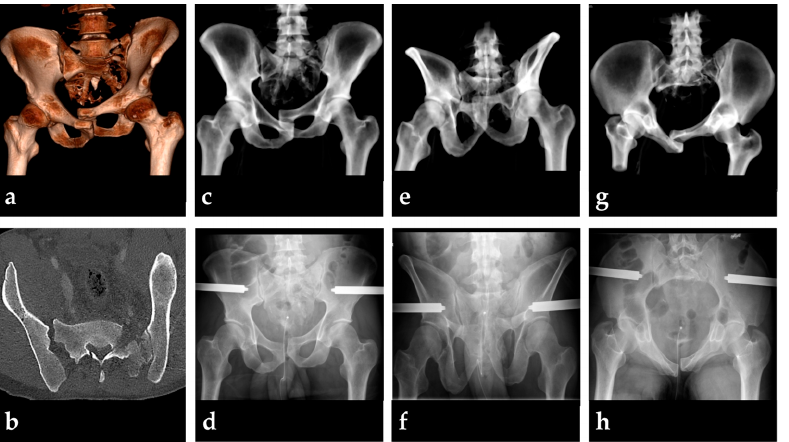
Figure 1. Example of an unstable pelvic fracture in a 40-year-old patient presenting at the emergency department with hemodynamic instability after falling from a 15 m height (ISS = 50, GCS = 13, initial lactate 5.8 mmol/L). A pelvic binder was placed in the prehospital phase and resulted in overreduction. A 3D reconstruction of the initial CT scans with the binder in place reveals the vertical shear pelvic injury pattern ( a ), with gross posterior instability resulting from bilateral transforaminal sacral fracture and unilateral sacroiliac dislocation ( b ). Initial fracture reduction and application were successfully performed using a pelvic C-clamp as shown in a.p., outlet, and inlet projections before ( c , e , g ) and after application ( d , f , h ). Application resulted in significant increases of sABP and MAP and a decrease in HR and SI, respectively ( p < 0.05).